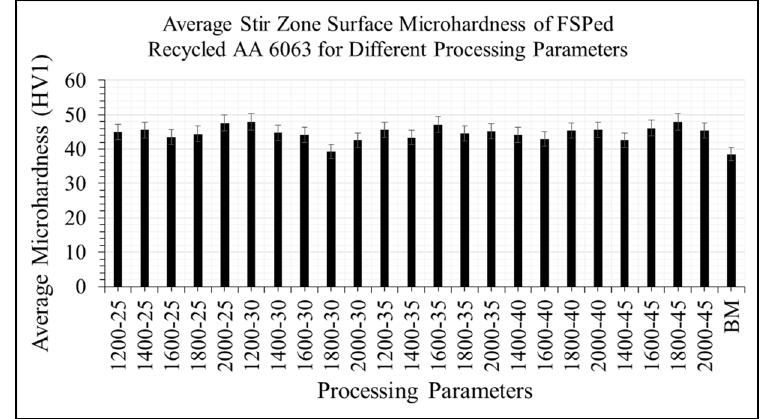
Figure 9. Average stir zone surface microhardness of FSPed samples.